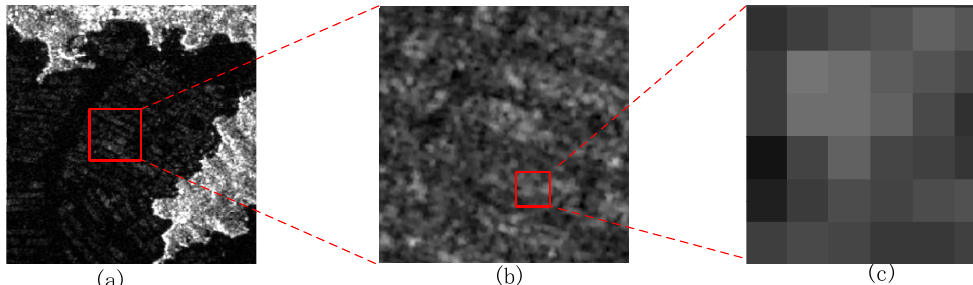
Figure 2. Difference in gray levels of a floating raft affected by noise. ( a ) The raft aquaculture area is globally distinguishable. ( b ) The local culture area is poorly characterized. ( c ) Differences in grayscale values exist at various pixels within the floating